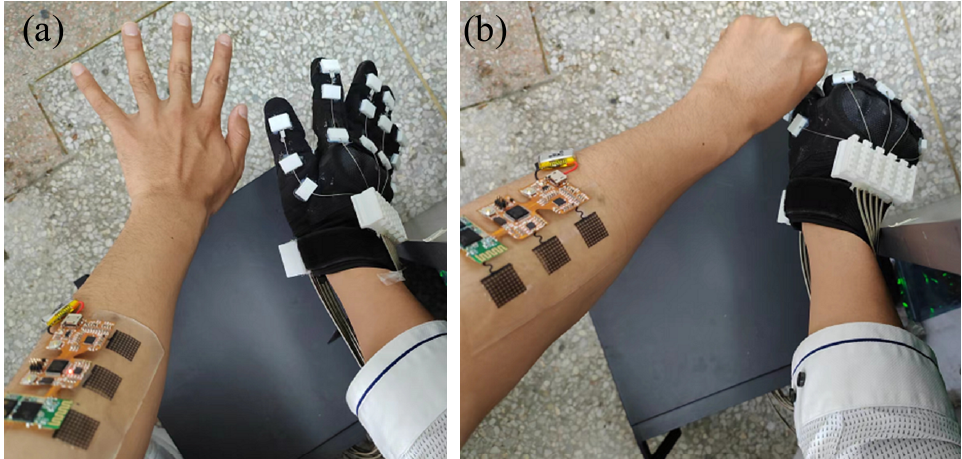
Figure 17. Rehabilitation application using flexible sEMG system. ( a ) Myoelectric signals from the left forearm control the opening of the right hand rehabilitation robot. ( b ) Myoelectric signals from the left forearm control the right hand rehabilitation robot to make a fist.